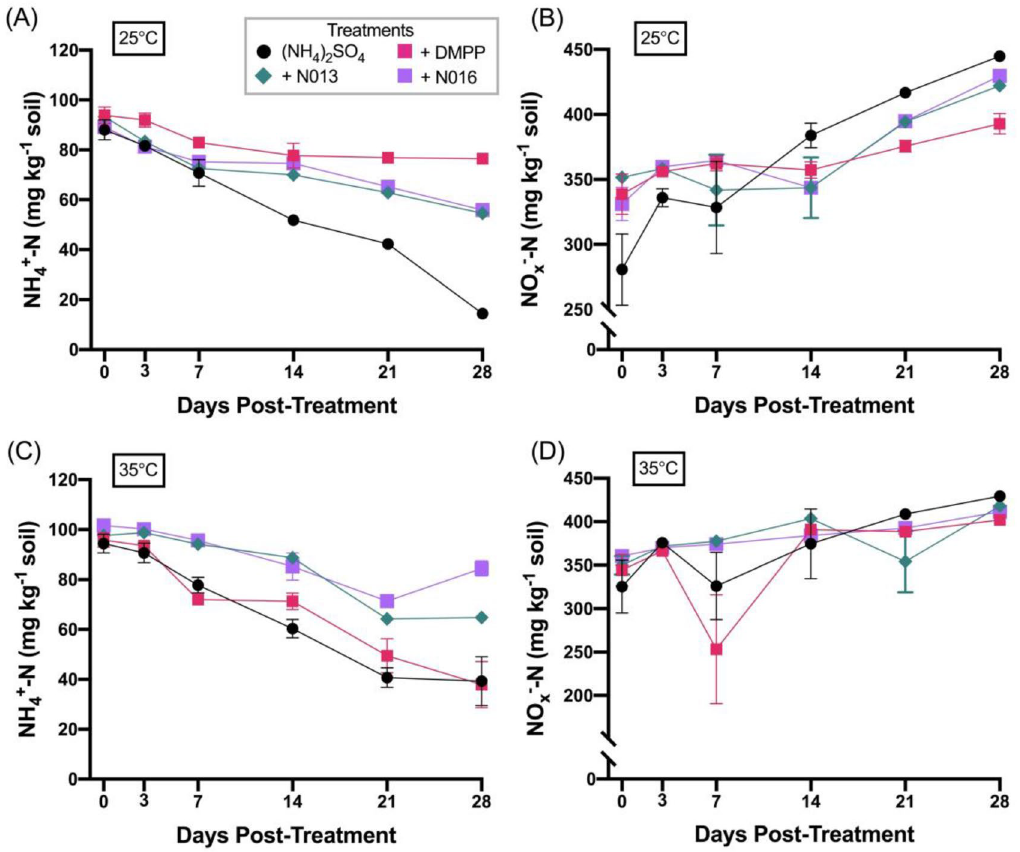
Figure 5. Measured NH 4 + -N ( A , C ) and NO x – -N ( B , D ) concentrations of Dahlen soil incubated at 25 °C ( A , B ) and 35 °C ( C , D ) over 28 days following treatment with: (NH 4 ) 2 SO 4 [Black circle], (NH 4 ) 2 SO 4 + DMPP [Pink square], (NH